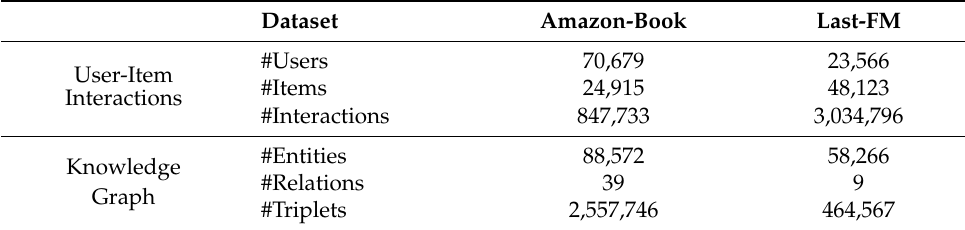
Table 2. Dataset